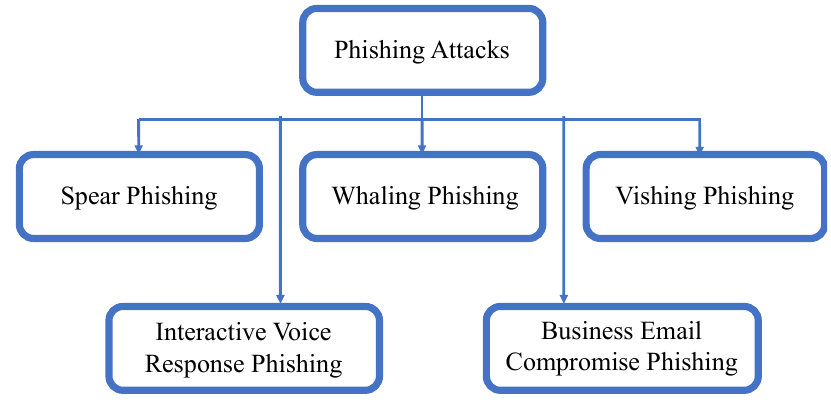
Figure 5. Phishing attacks.